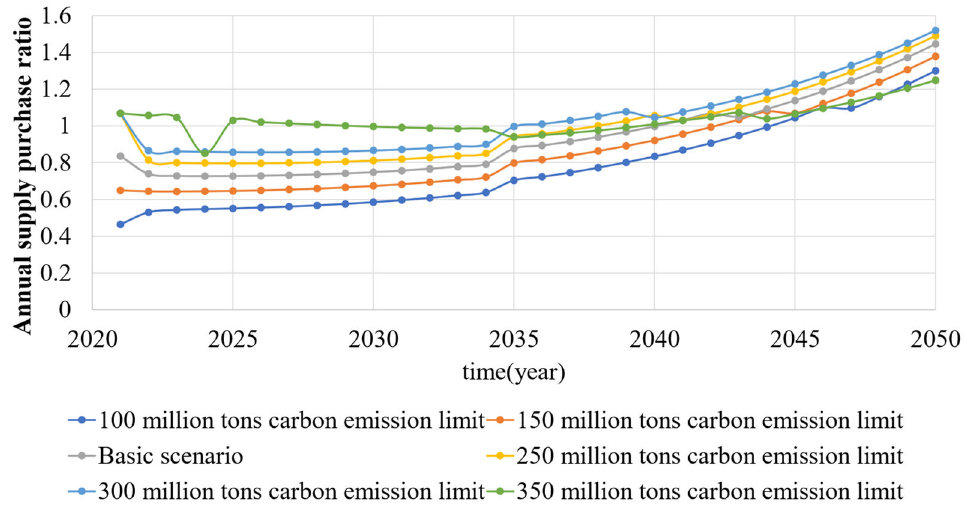
Figure 14. Simulation results of annual supply–purchase ratio based on carbon emission limit.